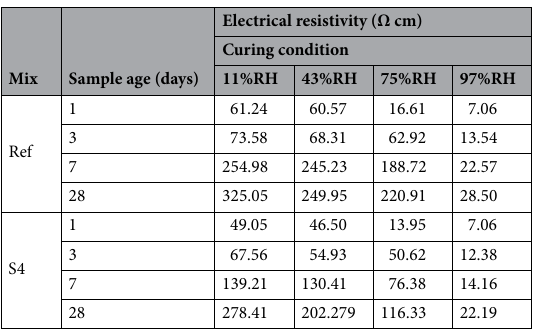
Table 2. Effects of sample age and curing conditions on electrical